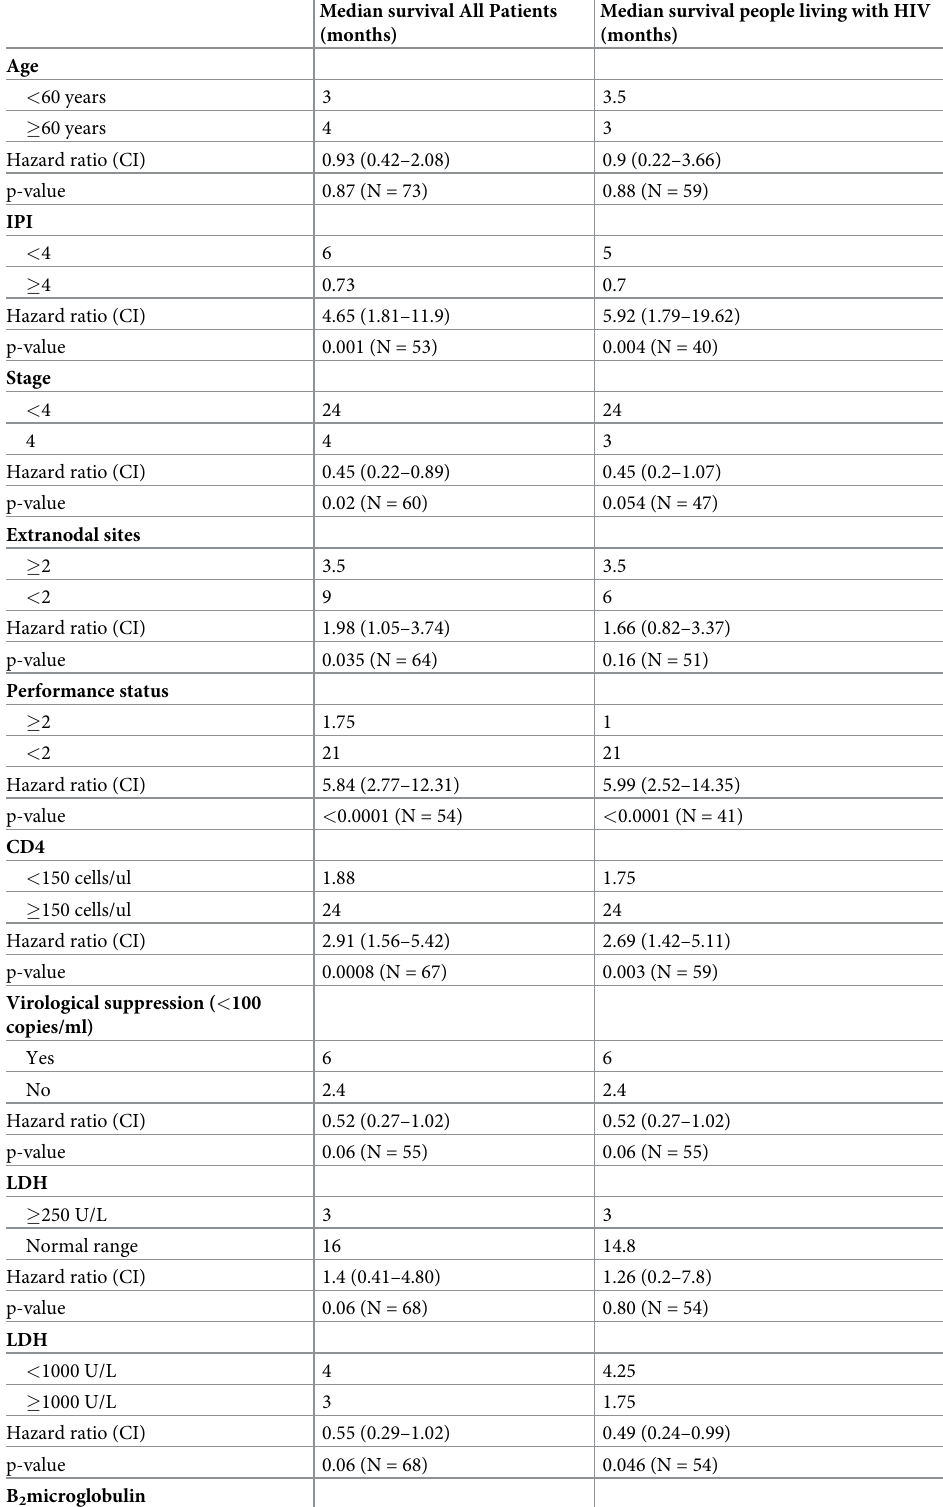
Table 4. Survival